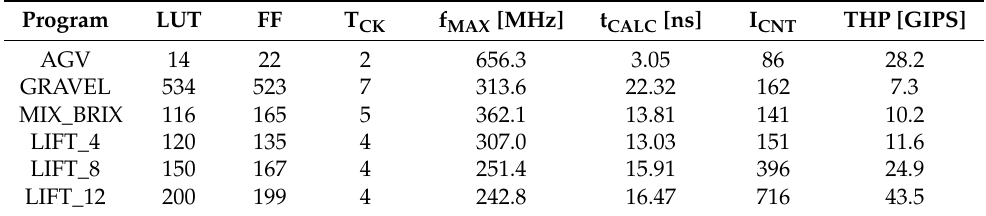
Table 2. Implementation results comparison for the test programs in the Artix-7 FPGA